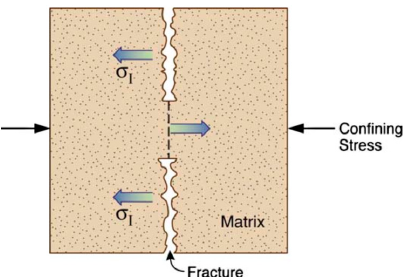
Figure 9. Graphical description of the internal swelling stress ([64]).